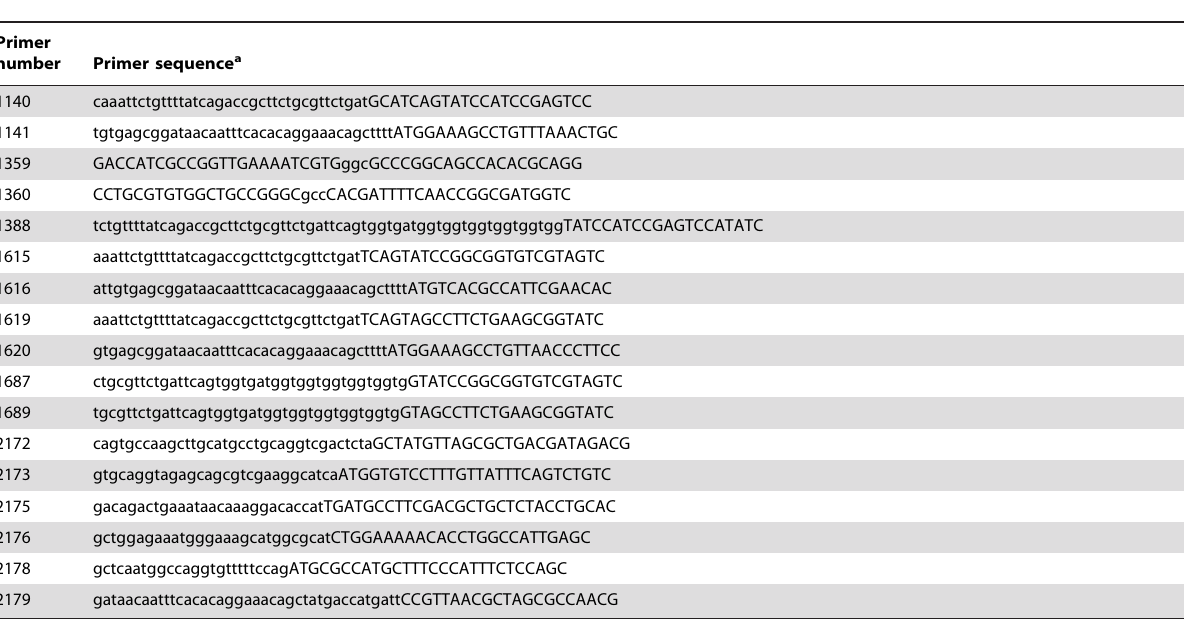
Table 3. Oligonucleotide primers used in this